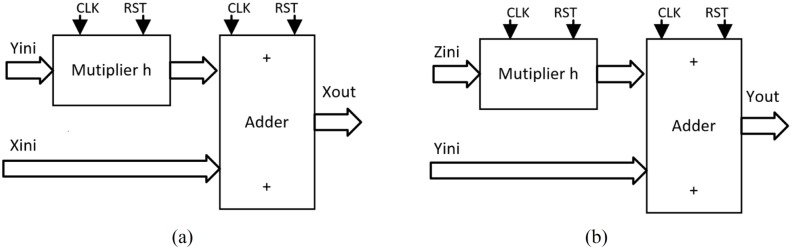
Hardware connection for implementing.(a) x[k + 1] = x[k] + hy[k], and (b) y[k + 1] = y[k] + hz[k] from Eq (10).